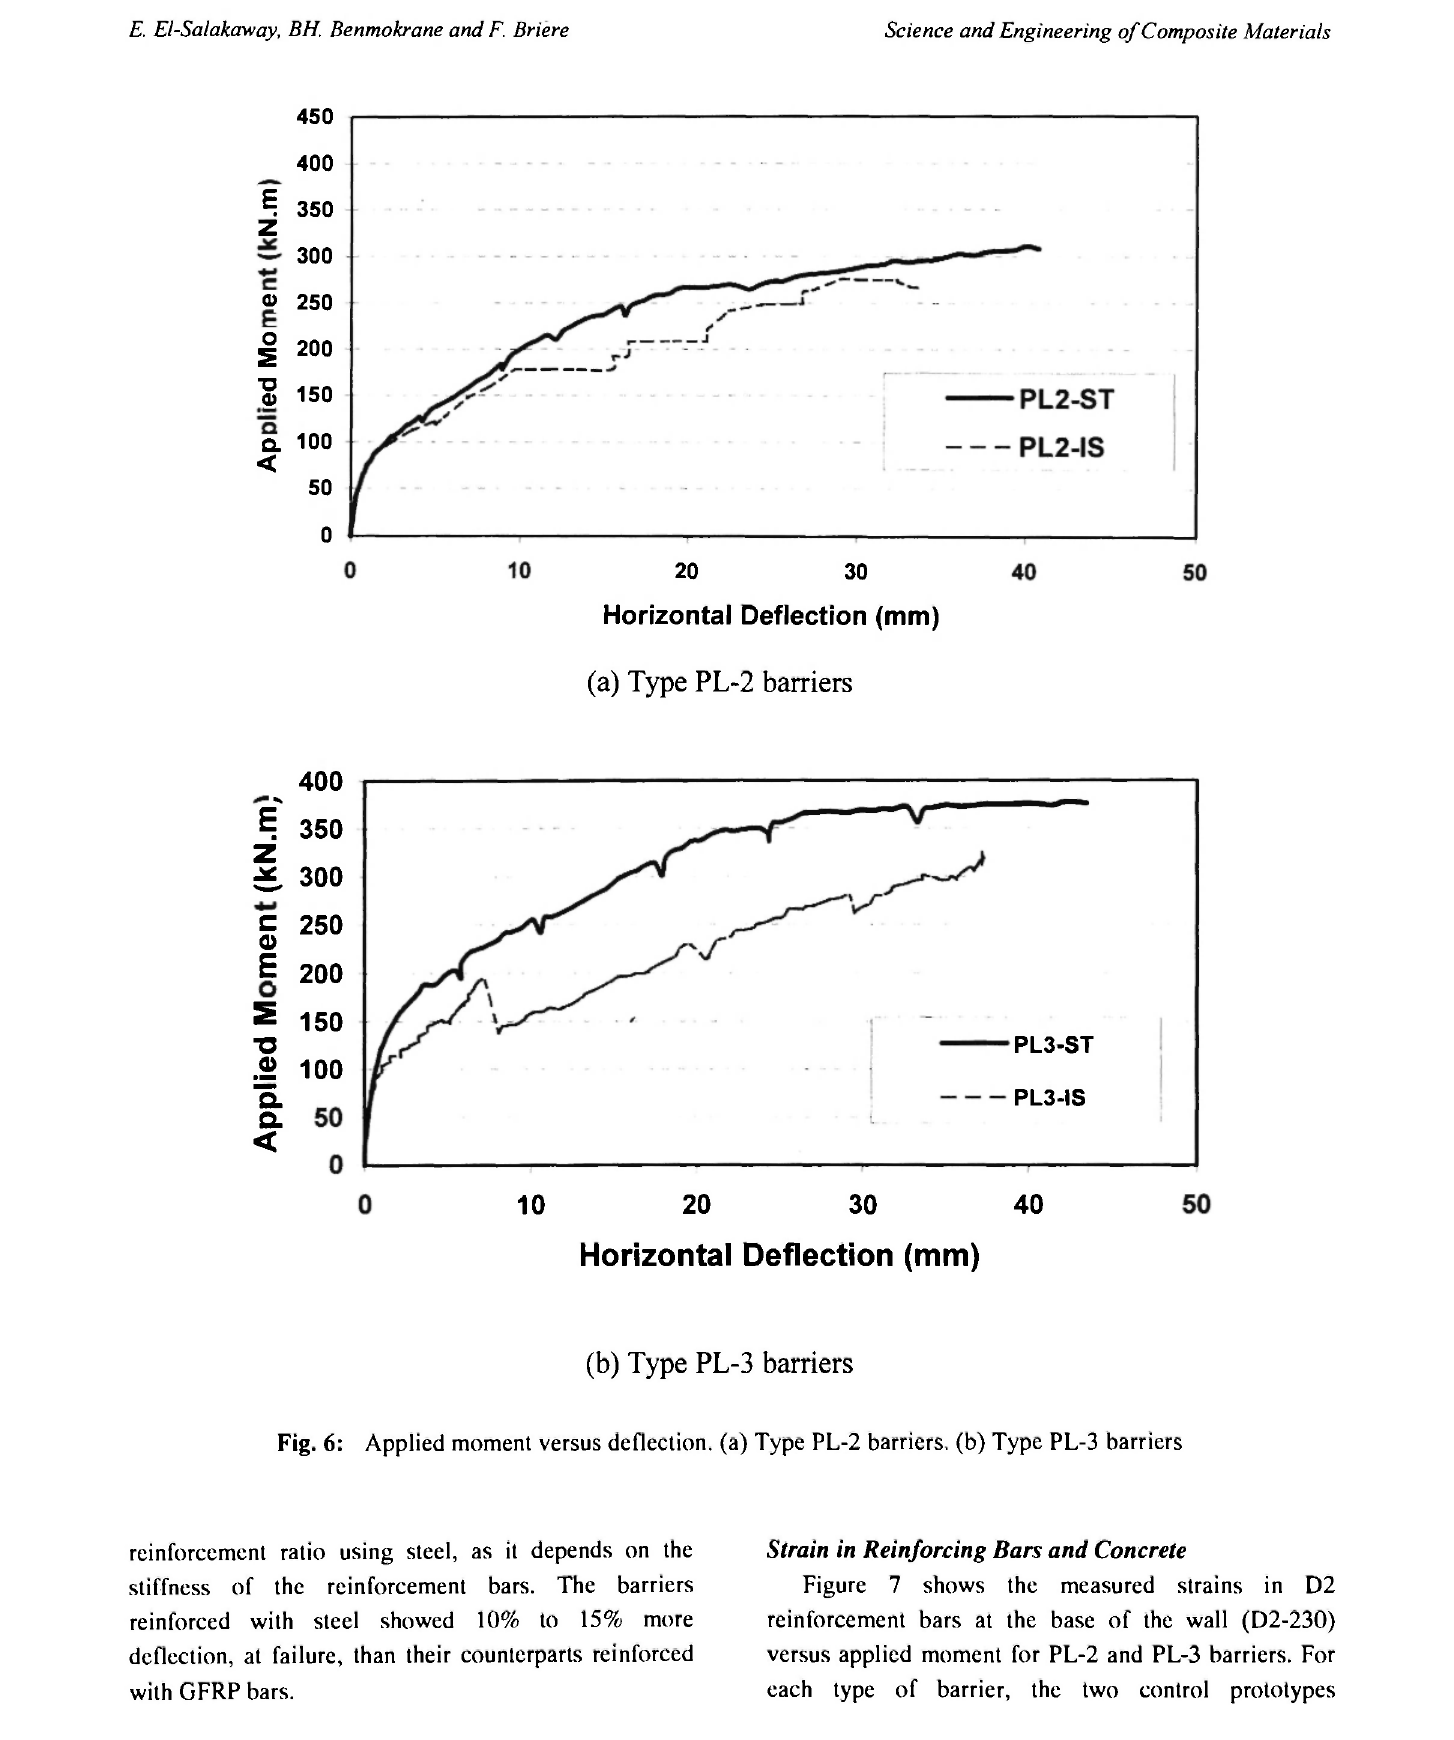
reinforcement ratio using steel, as it depends on the stiffness of the reinforcement bars. The barriers reinforced with steel showed 10% to 15% more dcflection, at failure, than their counterparts reinforced with GFRP bars.